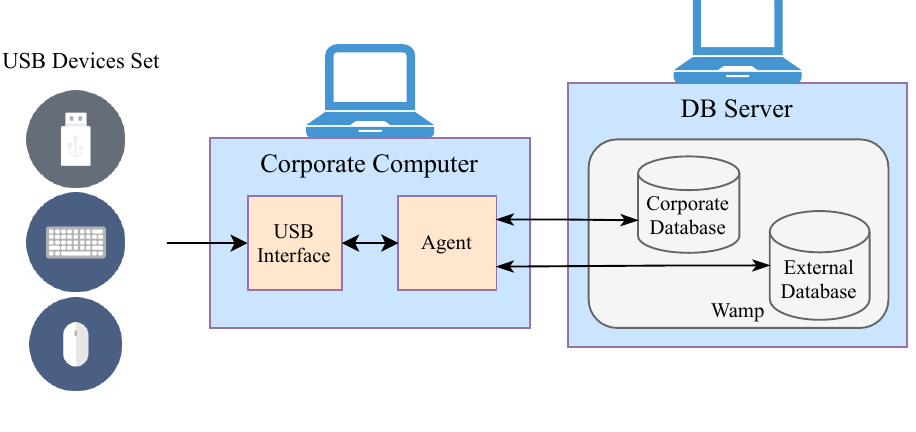
Figure 3. Test-bed